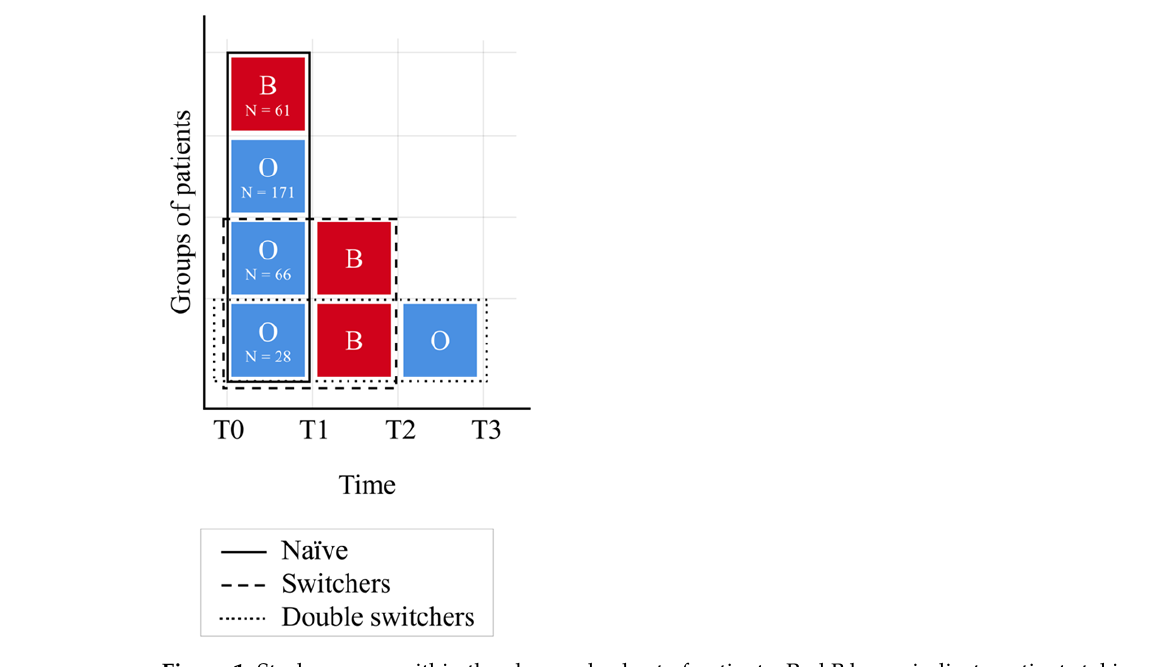
Figure 1. Study groups within the observed cohort of patients. Red B boxes indicate patients taking biosimilar, while blue O boxes indicate patients taking originator. Switch events are presented from left to right. Table 1. Baseline demographic and clinical characteristics of patients included in the non-switcher